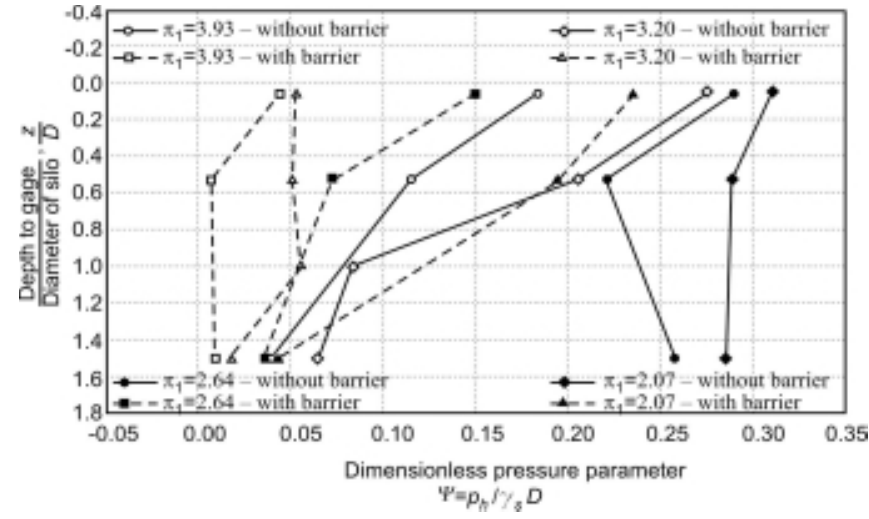
Fig. 24. Comparison of the horizontal pressure coefficient acting on the front of the wall with and without attenuation, as a function of π 1 = R/D for π 3 = 1.01 and π 6 = 4.0 · 10 − 4 . case i.e. for smaller charge-to-silo distance one can observe the best attenuation on the silo bottom and a poor barrier influence on the silo top, especially for π 1 = 2.07 with some influence of soil destruction caused by